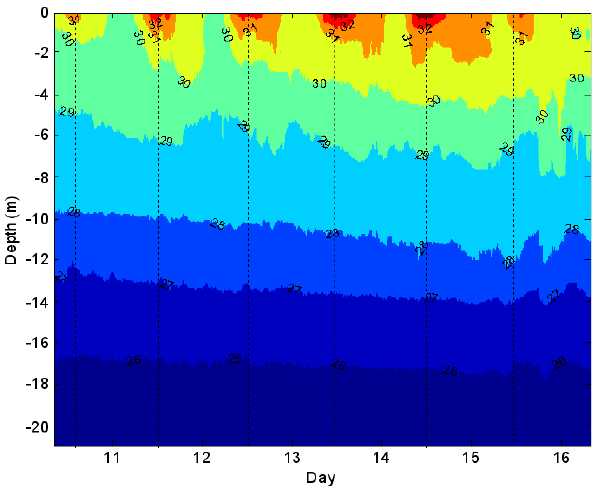
Figure 11: Temperature contours from the thermistor-chain data measured at the river- reservoir transition zone (January) (Station 06).